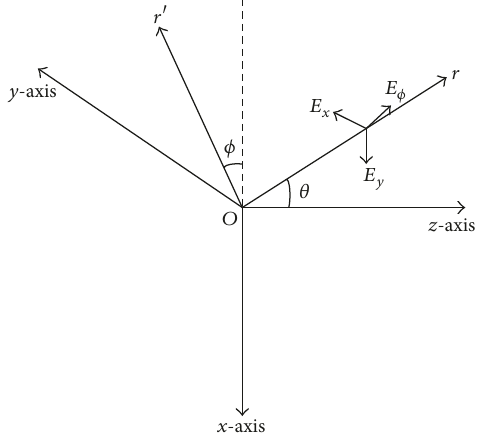
Figure 2: Radiated field of the